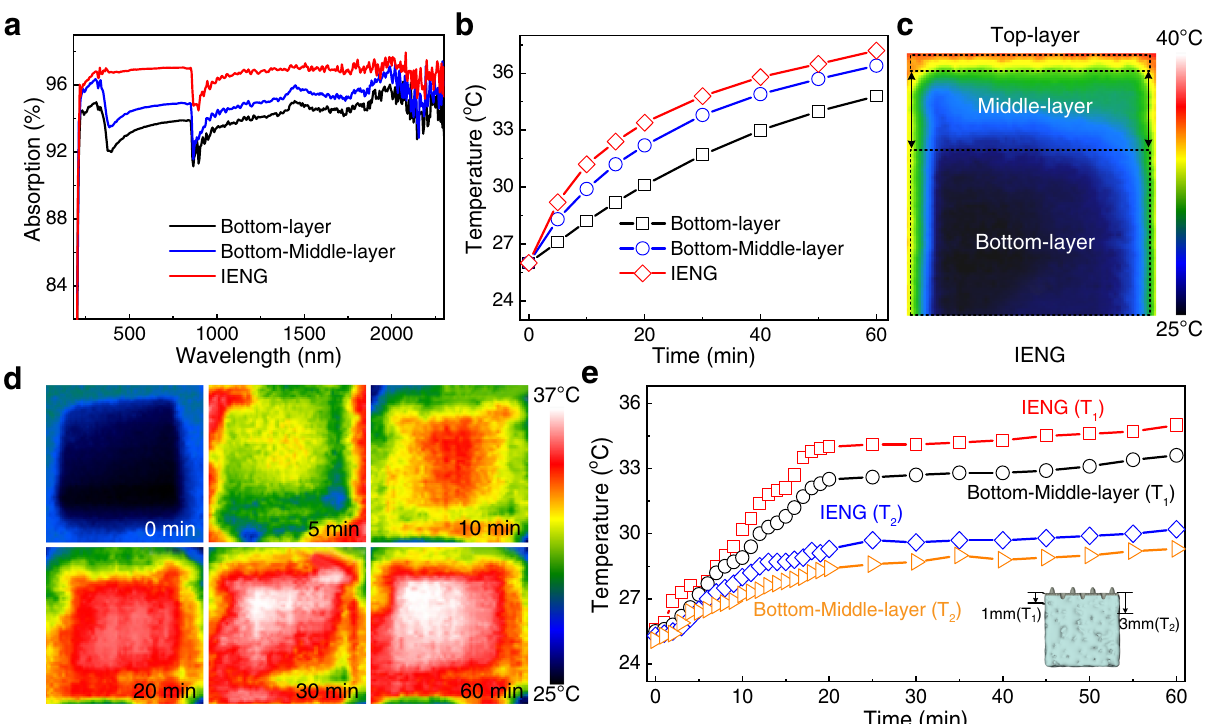
Fig.3|PhotothermalconversioncharacteristicsoftheIENGs.a Lightabsorption spectra of the IENGs in the wavelength range of 190 – 2500nm. b Surface tem- perature curves of the IENGs under a solar light intensity of 1.0kW· m − 2 . c Side